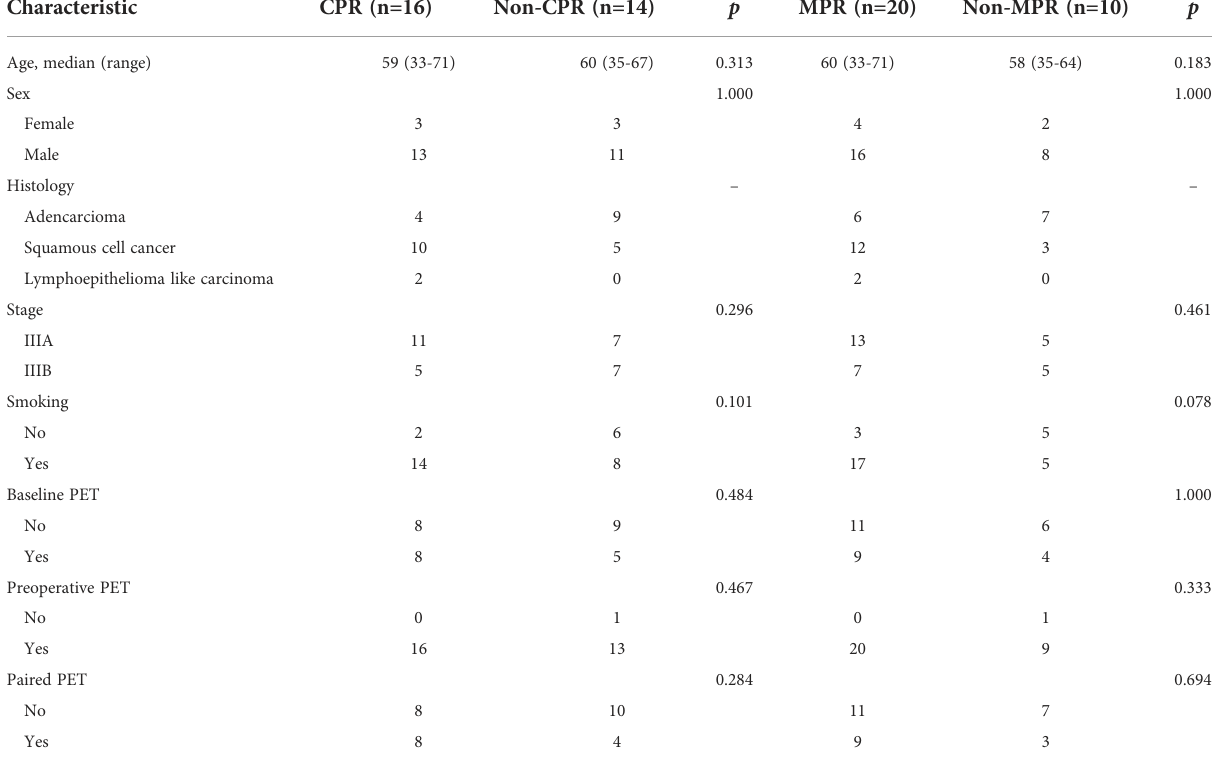
TABLE 2 General information between patients achieved complete pathological response (CPR) and Non-CPR, major pathological response (MPR) and Non-MPR. Characteristic